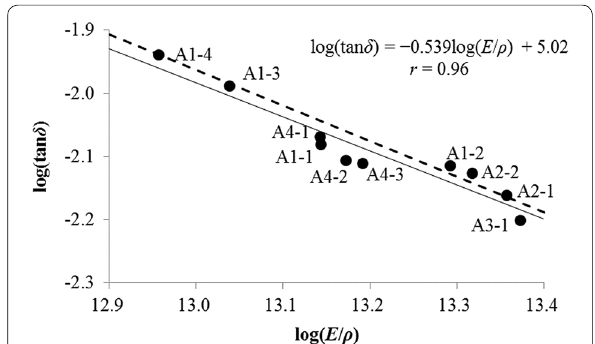
Fig. 2 Correlation between log ( E / ρ ) and log (tan δ ) for the Group A specimens. The solid line is the best-fit regression line for the Group A specimens. The dashed line is the best-fit regression line of hinoki small clear specimens from a previous report